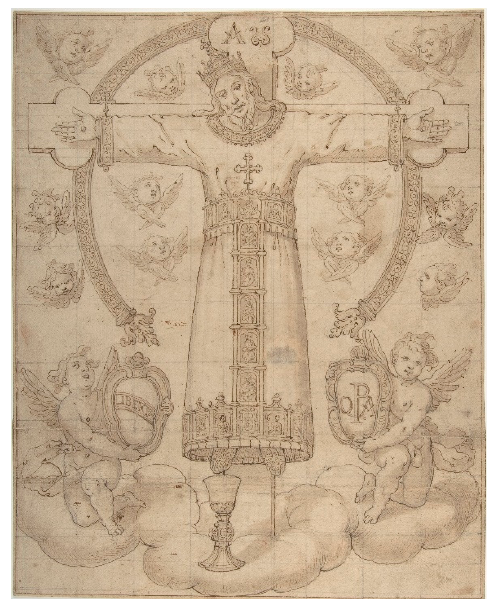
Figure 12. The Volto Santo in Lucca cathedral. Anonymous artist. Drawing, 16th century. New York, The Metropolitan Museum of Art, Inv. No. 61.211. Photo: The Metropolitan Museum of Art/Creative Commons.